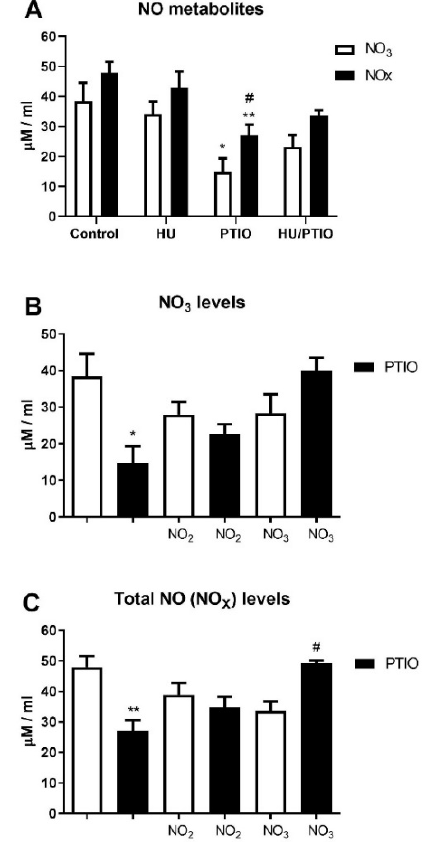
Figure 1. Nitric oxide derivatives in plasma of mouse peripheral blood. After 7 days of in vivo treatment by hydroxyurea (HU) ( A ), sodium nitrite (NO 2 ) and sodium nitrate (NO 3 ) ( B , C ), with or without PTIO, nitrate (NO 3 ) level ( A , B ) and total NO level (NOx) ( A , C ) were determined. Values are mean ± SEM ( n = 6). * p < 0.05, ** p < 0.01, vs. non-treated mice (Control); # p < 0.05 vs. HU ( A ) or PTIO ( C ) treated only. Table 1. Hematologic parameters in peripheral blood and weight of treated mice